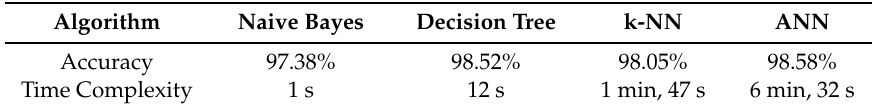
Table 2. Comparison of classifiers run on Raspberry Pi.